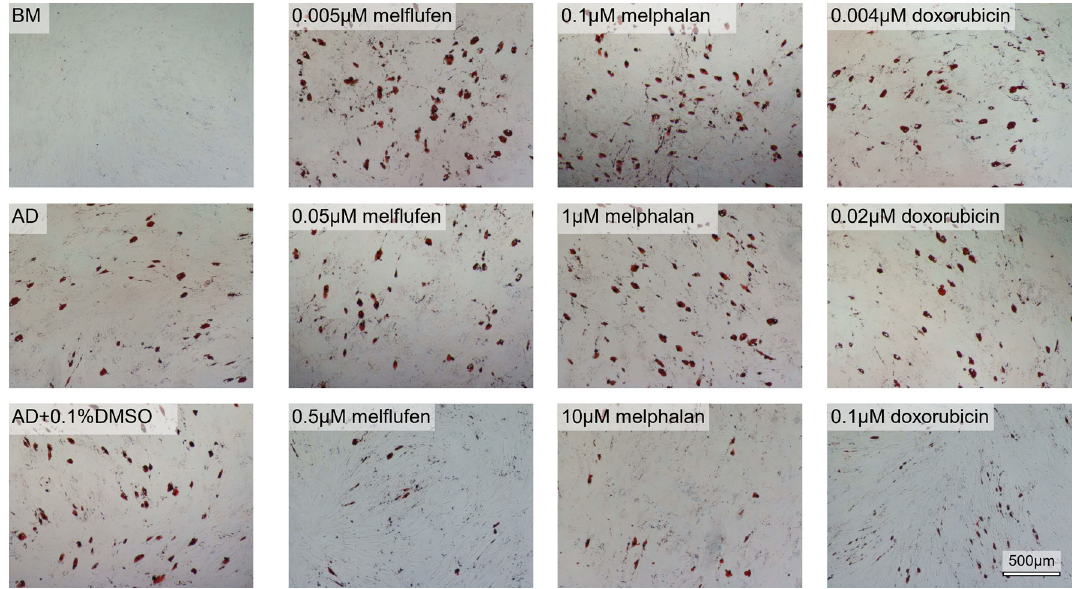
Figure 5. Fat droplet formation in adipogenic differentiation of BMSCs in the presence of drugs. Oil Red O stains lipid droplets red in BMSCs after 3 weeks of culture in adipogenic differentiation (AD) conditions with melflufen, melphalan, doxorubicin, and DMSO added at indicated concentrations. BM, basic medium control. Scale bar: 500 µm.